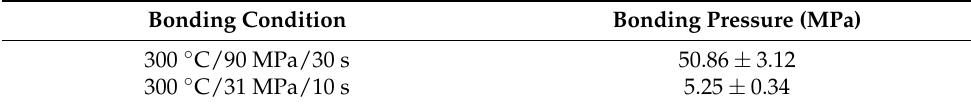
Table 1. Bonding strength of two bonding conditions.